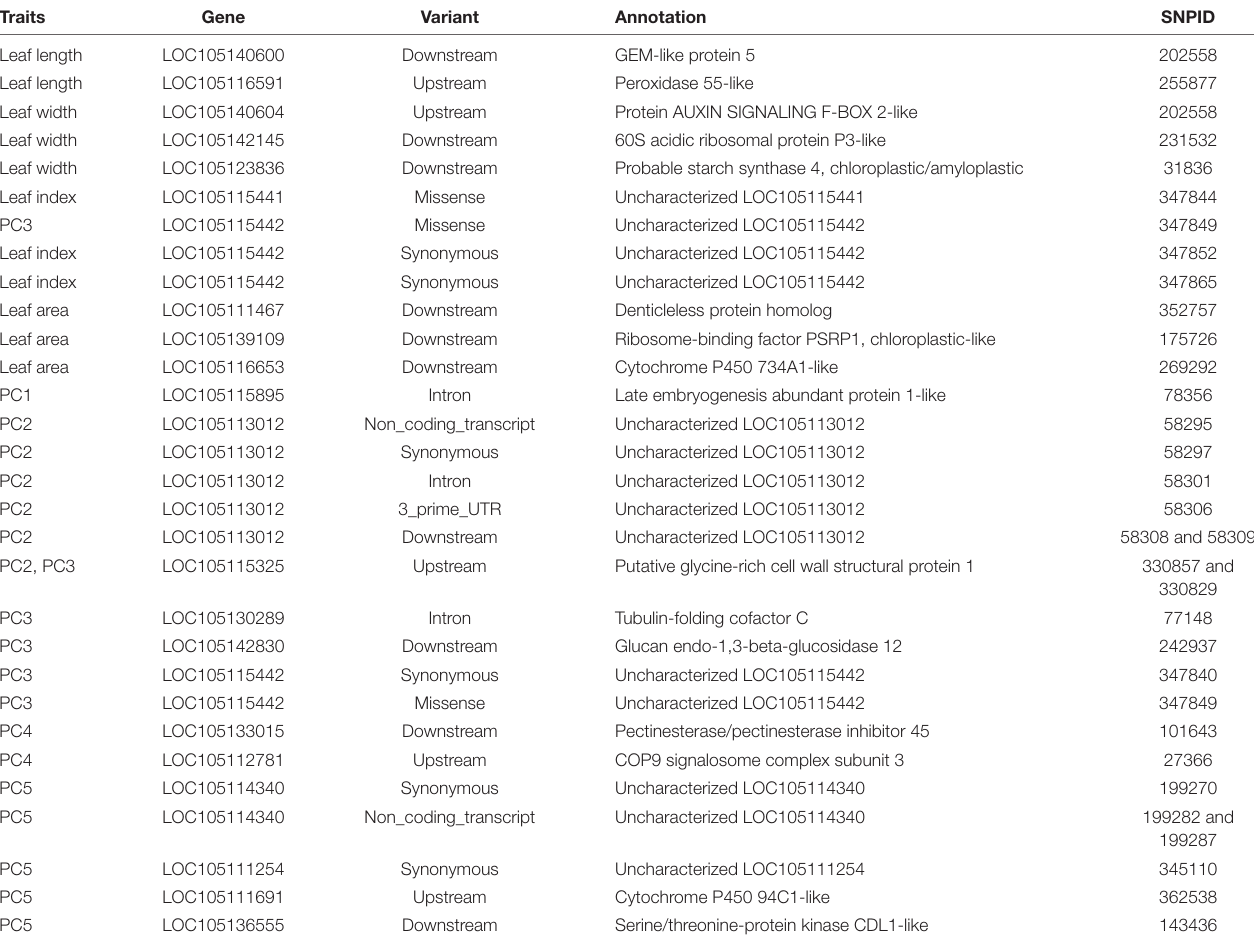
TABLE 2 | Candidate genes identified according to significant SNPs for the different traits based on multi-leaf GWAS. Traits